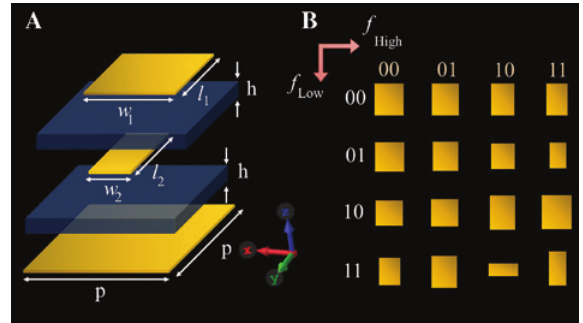
Figure 2: Reflection-type digital meta-atoms and EM response of all 16 coding